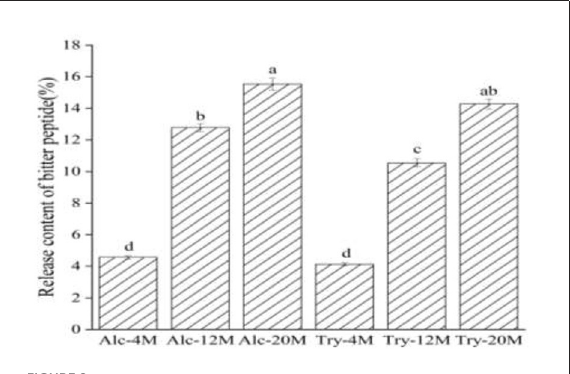
FIGURE2 Release content of bitter peptides in different extracts. The values in a column followed by different letters were significantly different ( p < 0.05).